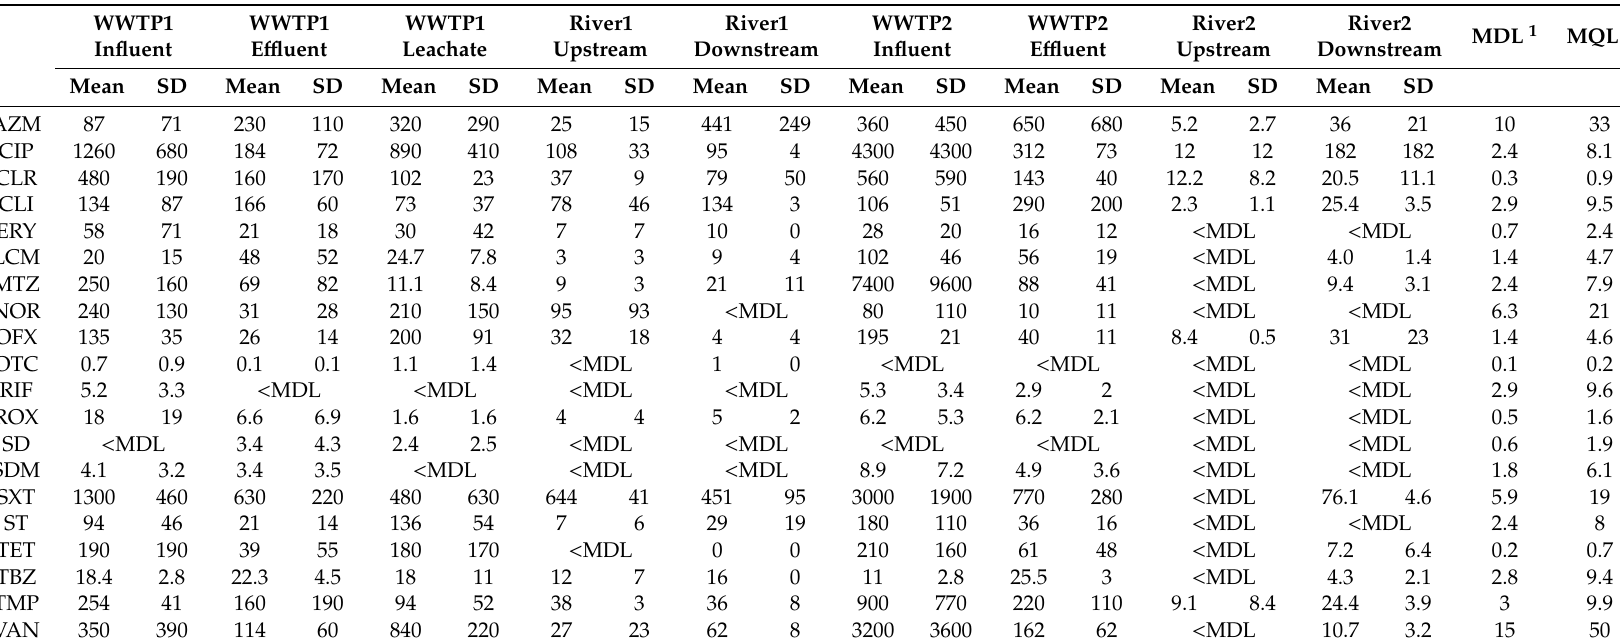
Table 1. Mean and standard deviation ( n = 3) of the target antimicrobial concentrations (ng / L) in influent, e ffl uent, and receiving water of two wastewater treatment plants (WWTPs) located in Poland at Silesian (WWTP1) and Warmian-Masurian Voivodship